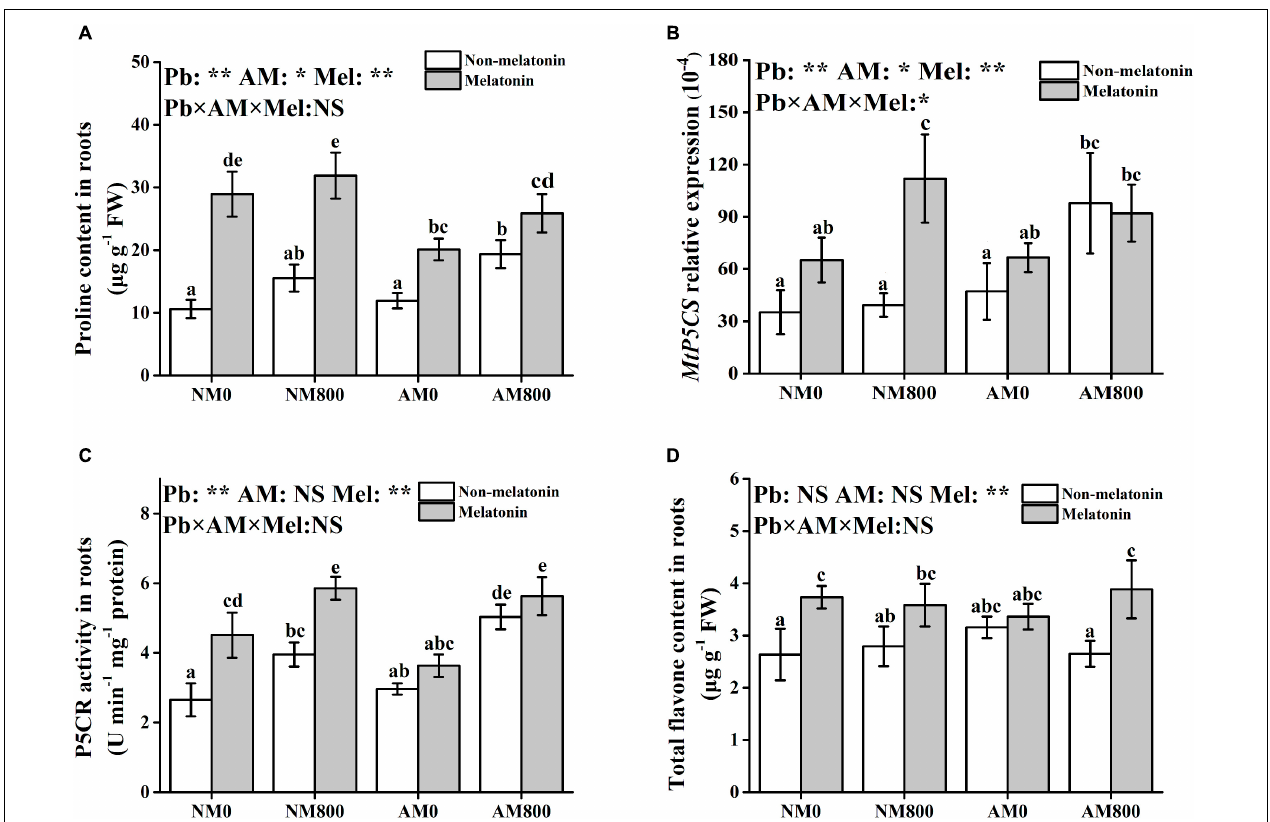
FIGURE 5 | (A–D) The proline content, MtP5CS expression, P5CR activity, and total flavone content of AM roots under Pb stress and melatonin application. The data are the means ± standard deviation ( n = 4). Different letters above the columns indicate significant difference among the means by Tukey HSD’s test ( P < 0.05), * P < 0.05, ** P < 0.01; NS, not significant. The abbreviation is consistent with the